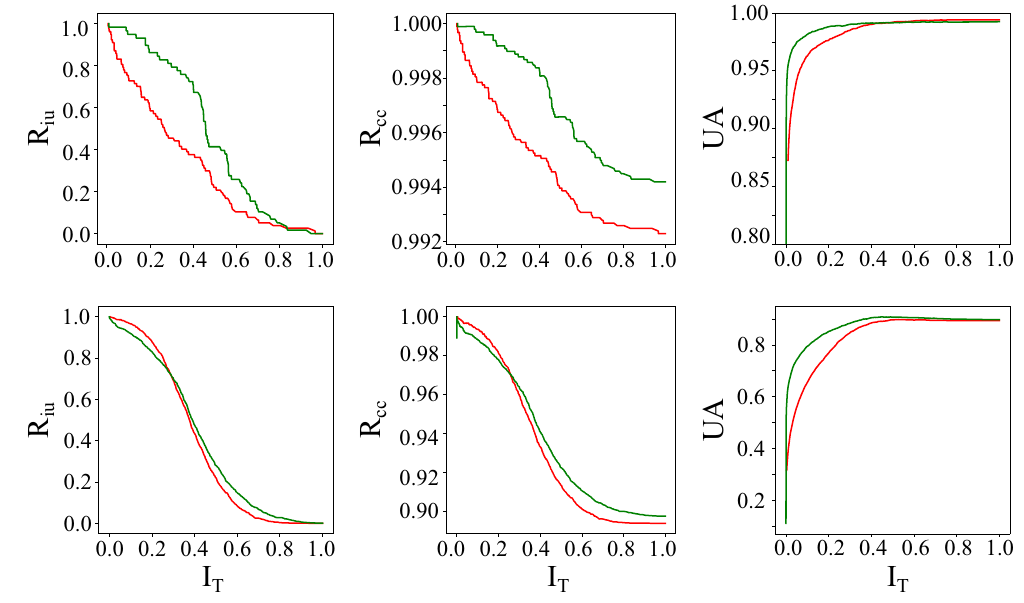
Figure 2. Illustrating the quantitative uncertainty estimation performance for the classification task using the proposed evaluation metrics. Note that when varying the uncertainty threshold, our proposed MC-DropConnect approximated BNN (shown in green) generally performs better than MC-Dropout (shown in red) for both MNIST (Top) and CIFAR-10 (Bottom)